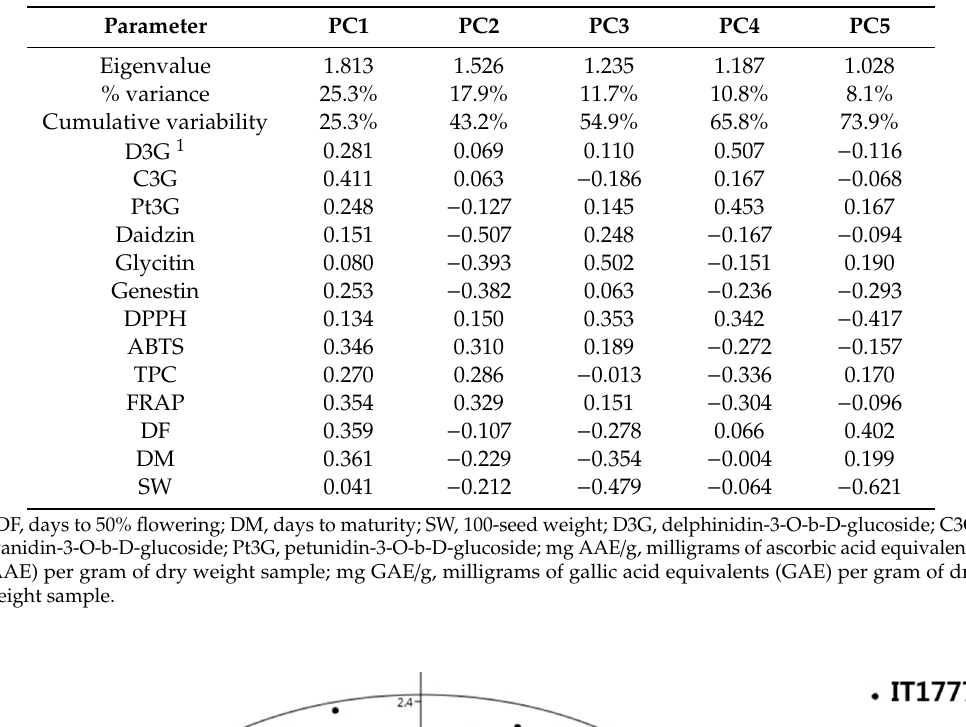
Table 5. Average cluster values of agricultural traits, phytochemicals, and antioxidant activities of 172 Korea black soybean landraces.